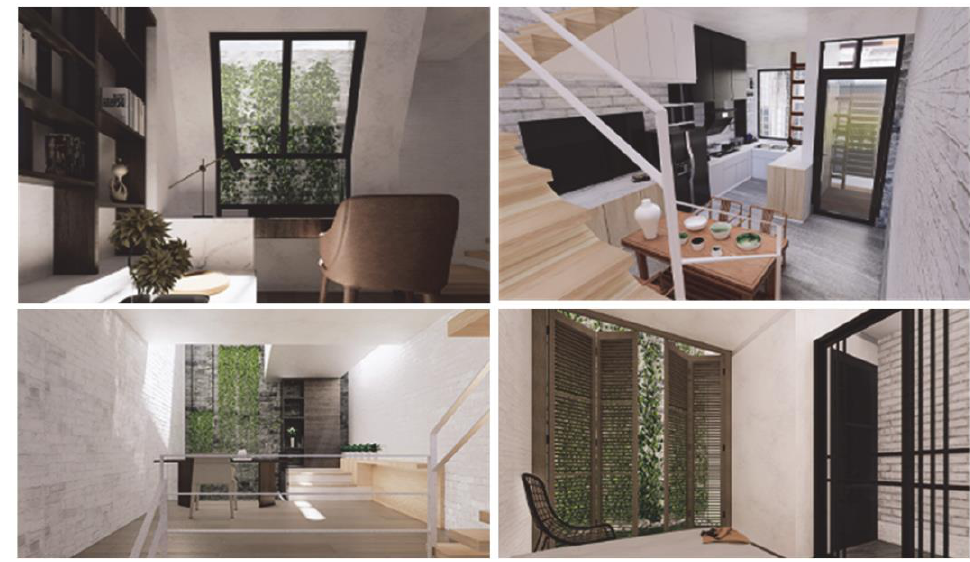
Figure 22. Rendering of the interior space of a concept design (drawn by the students).